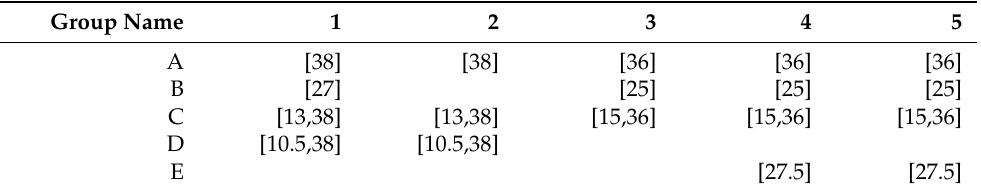
Table 1. Hishape groups of Spliced Leader RNAs from five different species, namely (1) Leptomonas